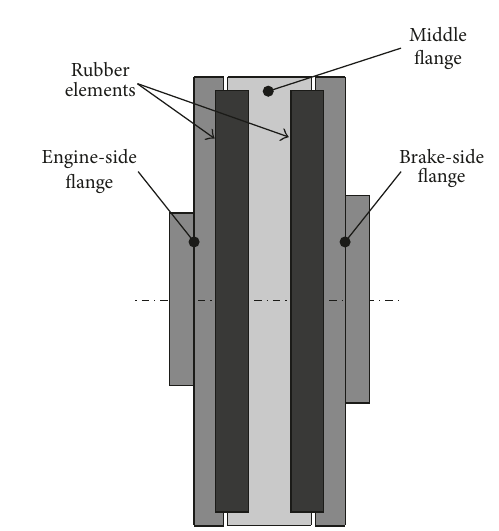
Figure 3: Schematic of the highly flexible coupling with rubber